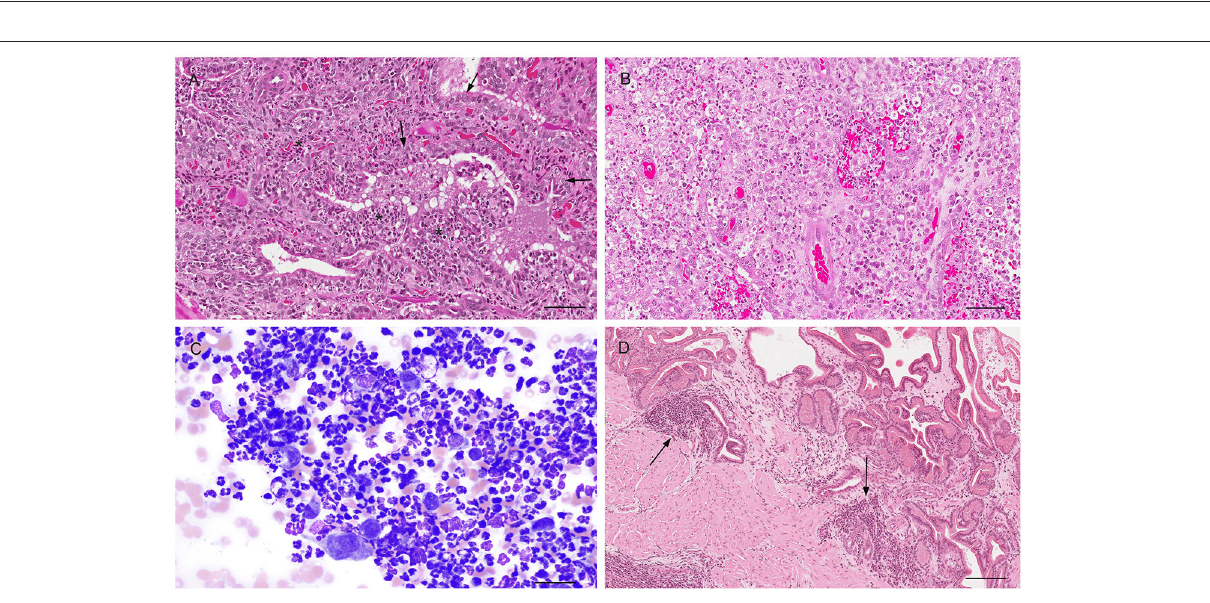
FIGURE 7 | Histological (A,B,D) and cytological (C) features of three different types of prostatitis in dogs (A) . Acute prostatitis with infiltration of high number of neutrophils (asterisks) and occasional reactive changes in the glandular epithelial cells (large nuclei, prominent nucleoli) (arrows). Hematoxylin-eosin staining. Bar = 60 µ m. (B) Infiltration of high number of neutrophils and macrophages with severe destruction of the gland (pyogranulomatous prostatitis). Hematoxylin-eosin staining. Bar = 60 µ m. (C) Prostate aspirate showing cytological features of acute prostatitis with high number of neutrophils with minimal nuclear degeneration and rare prostatic epithelial cells. Prostate FNA, cytospin. Wright-Giemsa stain. Bar = 30 µ m. (D) Mild multifocal chronic lymphoplasmacytic prostatitis (arrows). Hematoxylin-eosin staining. Bar = 120 µ